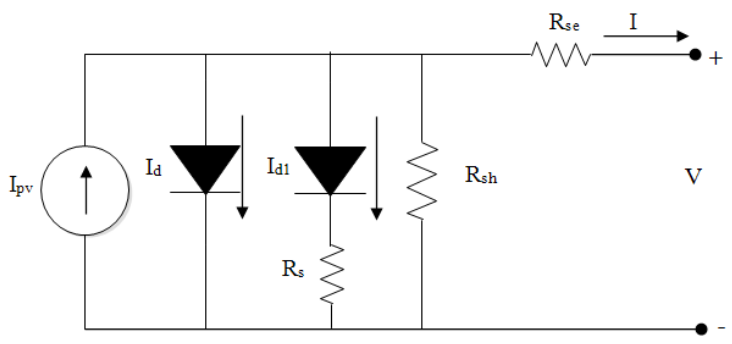
Figure 3. Schematic diagram of the modified double-diode PV model.